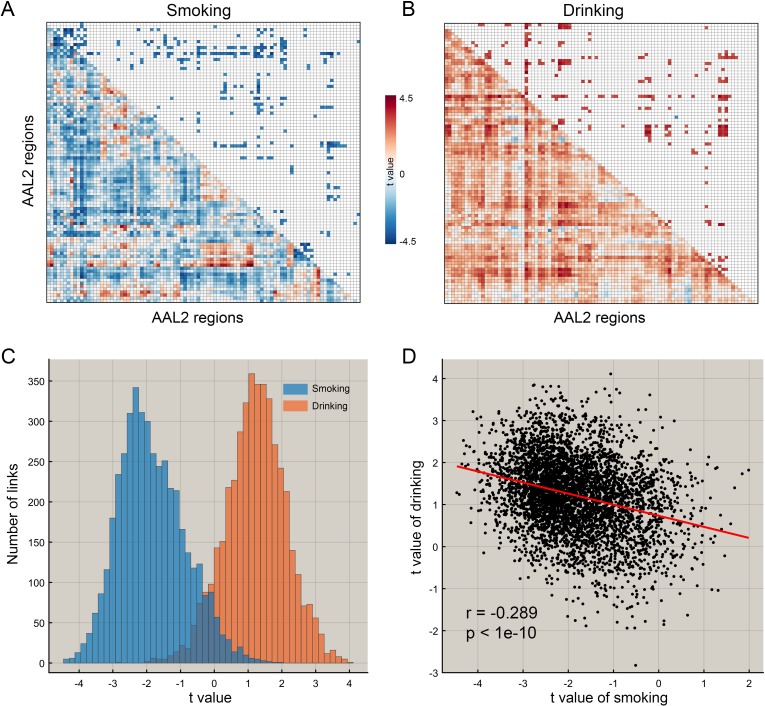
The difference of functional connectivity in smoking group and drinking group.(A) The matrix of t values for the smoking group. The lower triangle matrix shows the functional connectivities significantly associated with smoking. The baseline for the smoking was the never smoking group. The upper triangle matrix shows the significant links after multiple comparison correction (FDR corrected, p<0.005; no positive link survived correction for multiple comparisons). The regions are the AAL2 regions in the order shown in Supplementary file 1. (B) The matrix of t values for the drinking group. The lower triangle matrix shows the functional connectivities significantly associated with the amount of drinking per day. The baseline for the drinking was the low drinking group. The upper triangle matrix shows the significant links after multiple comparison correction using FDR correction (FDR corrected, p<0.05). The regions are the AAL2 regions in the order shown in Supplementary file 1. (C) The distribution of t values for the two groups for all AAL2 functional connectivity links. (D) The correlation between the t values of the above contrasts for the drinking and smoking groups. A positive t value indicates a stronger FC in a substance use group compared to the control group here and in the other Figures.